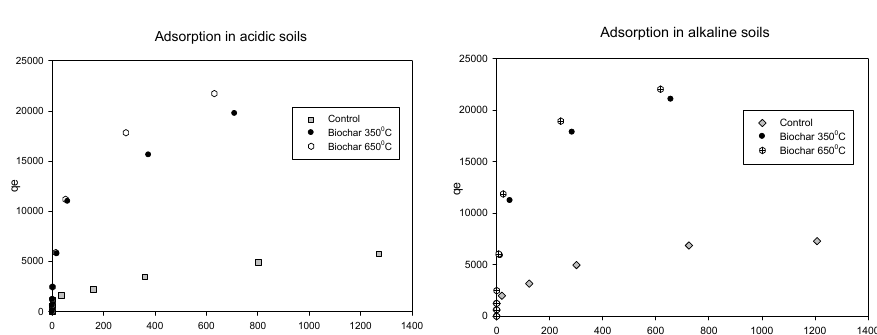
Adsorption in acidic soils